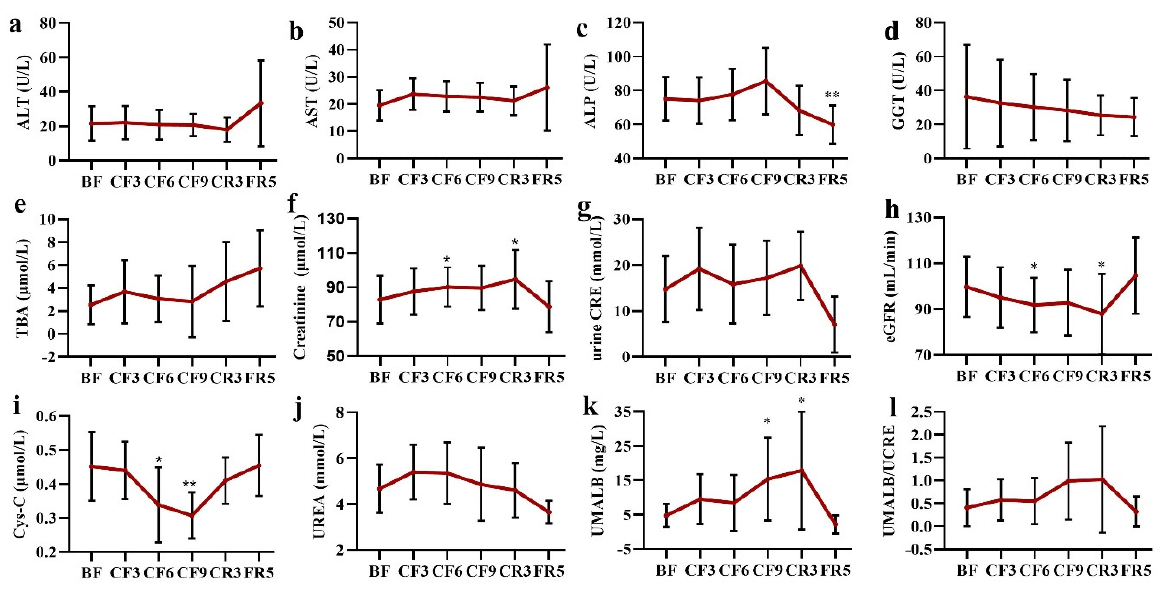
Figure 7. The alteration of liver ( a – e ) and kidney ( f – l ) function indexes during 10 ‐ day